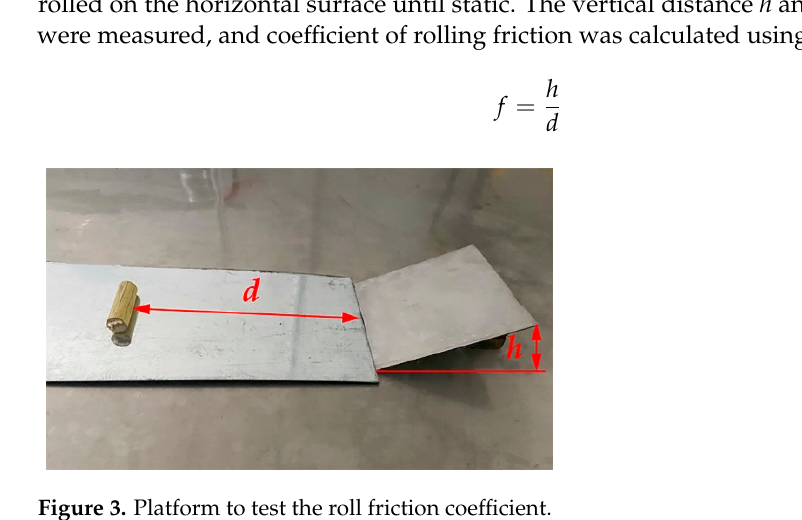
Figure 4. Platform to test the restitution coefficient. Table 7. The physical properties of characterizing contact between components.